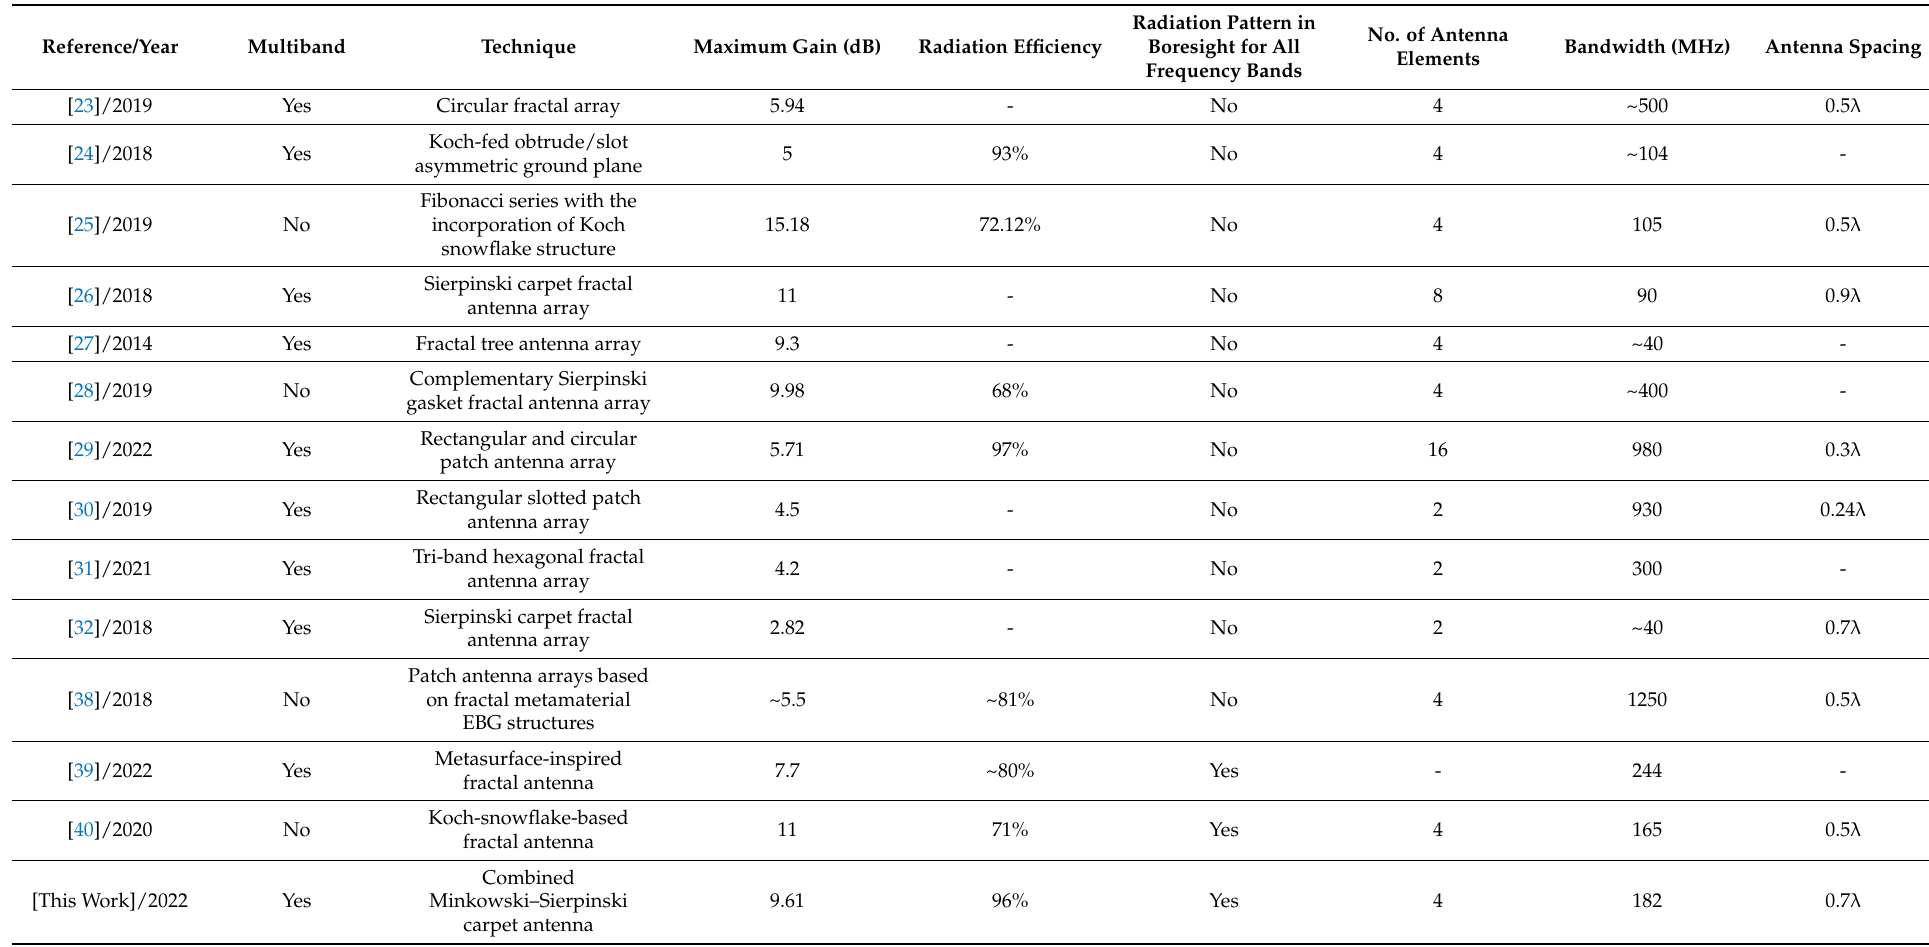
Table 3. Performance comparison of proposed four-element MSFAA with existing research literature where other researchers have proposed antenna arrays using fractal